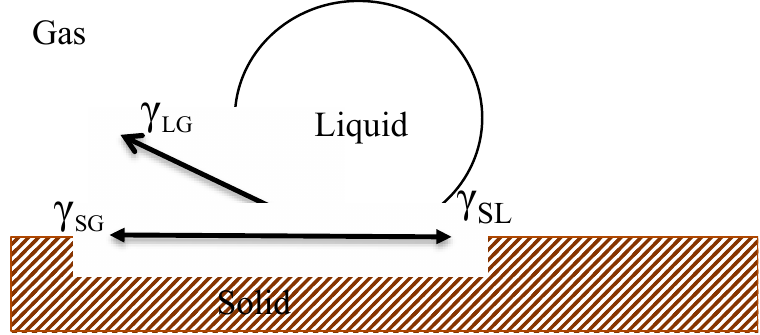
Figure 3. Schematic example of contact angle measurement.